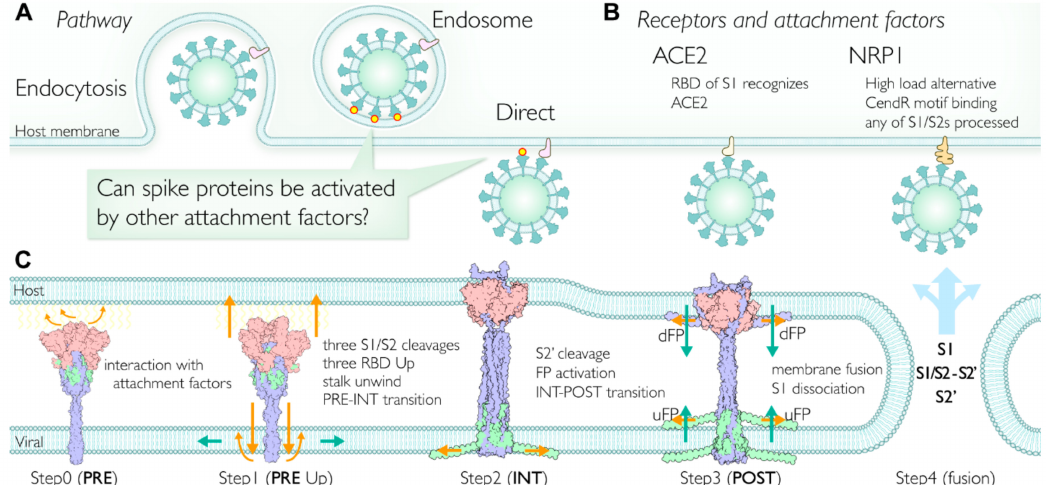
Figure 5. Proposed viral membrane fusion mechanism. ( A ) Two major pathways for cell entry. Direct entry is the primary pathway; however, endocytosis is also utilized. After the receptor binding, spikes may have more opportunities to facilitate the fusion steps by interacting with other attachment factors. ( B ) Typical receptors of SARS-CoV-2 for the membrane fusion. ACE2 is a primary receptor; however, the C-terminal of S1 subunit binds to neuropilin 1 (NRP1). The NRP1 pathway is considered to be utilized when the viral load is high. Note that the CendR motif binding to NRP1 is a unique insertion at the S1/S2 site in the SARS-CoV-2 spike. ( C ) The membrane fusion mechanism proposed in this study. Step 0 (PRE state): After binding a primary receptor such as ACE2, some spikes approach the surface of the host membrane. The RBDs are in thermal equilibrium, taking Up and Down forms. Soluble proteases such as furin can cleave the S1/S2 site in the spike during or before circulation (Table S8). Step 1 (PRE state RBD Up forms): A spike trimer approaches the host membrane surface and interacts with any attachment factors (Table S7) on the membrane surface, leading to the equilibrium shift toward the RBD Up form. Step 2 (INT state): The intermediate (INT) state between PRE and POST states before the S2 (cid:48) cleavage. A structural transition to INT is triggered by the conditions (RBD Up forms, S1/S2 cleavages). When the two conditions are satisfied, subsequently the unwinding of the stalk occurs, which unlocks the structural transition (untwisting activation mechanism). As a result of the structural transition from PRE to INT, the stalk in S2 (cid:48) unfolds toward the host membrane and wraps around the S1 trimer. Concurrently, the stem integrates into the viral membrane and N-terms of S1/S2-S2 (cid:48) expand onto the inner surface of the viral membrane to stabilize the stem. The S1 trimer is facing against the host membrane surface, and eventually the S1 trimer integrates into the host membrane. Step 3 (POST state): The S2 (cid:48) cleavage event activates two pieces of fusion peptides (uFP and dFP) located at the S2 (cid:48) cleavage site and triggers membrane fusion. In concert with the N-term of S1/S2-S2 (cid:48) , uFP and dFP moderate and facilitate the curvature of the membrane. Step 4: Viral and host membranes are fused. S1 subunits dissociate and are shed into the host cell. The rest of the proteolytically processed spikes, namely the S1/S2-S2 (cid:48) and S2 (cid:48) subunits, are possibly disassembled and delivered into the host cell as well (PRE, INT, and POST structures are colored by